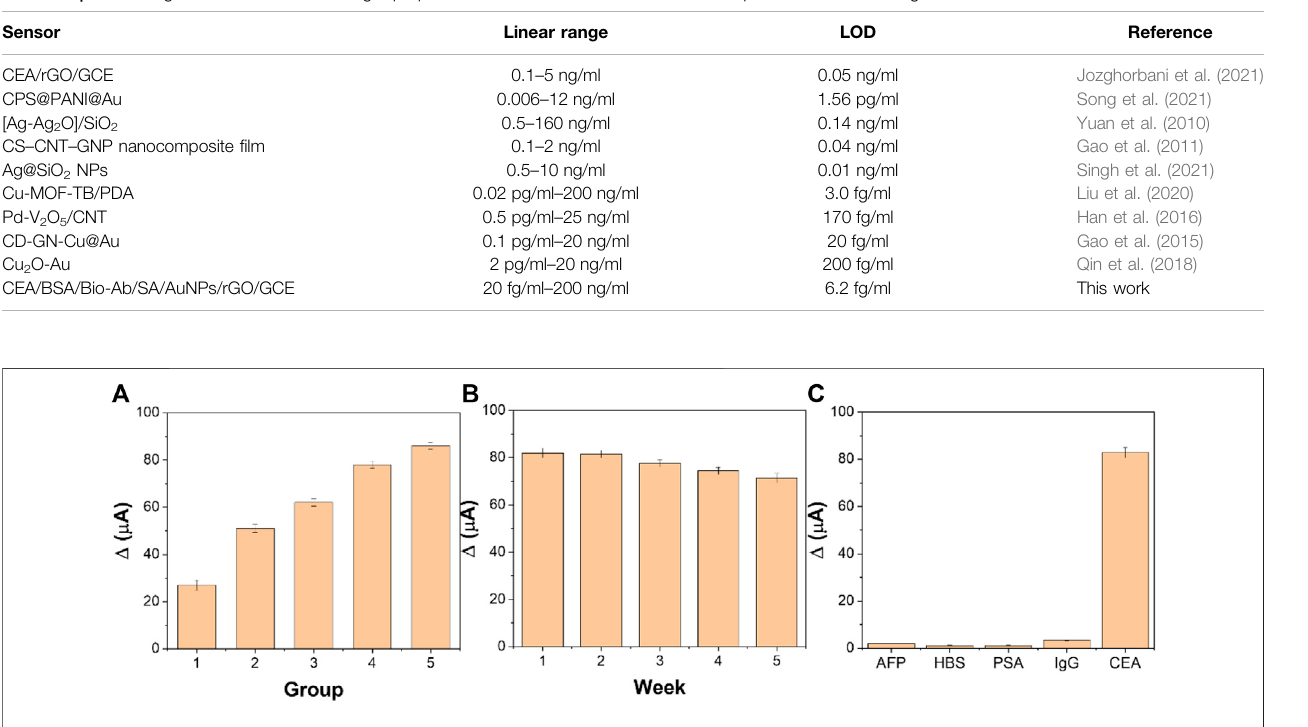
Frontiers in Chemistry |